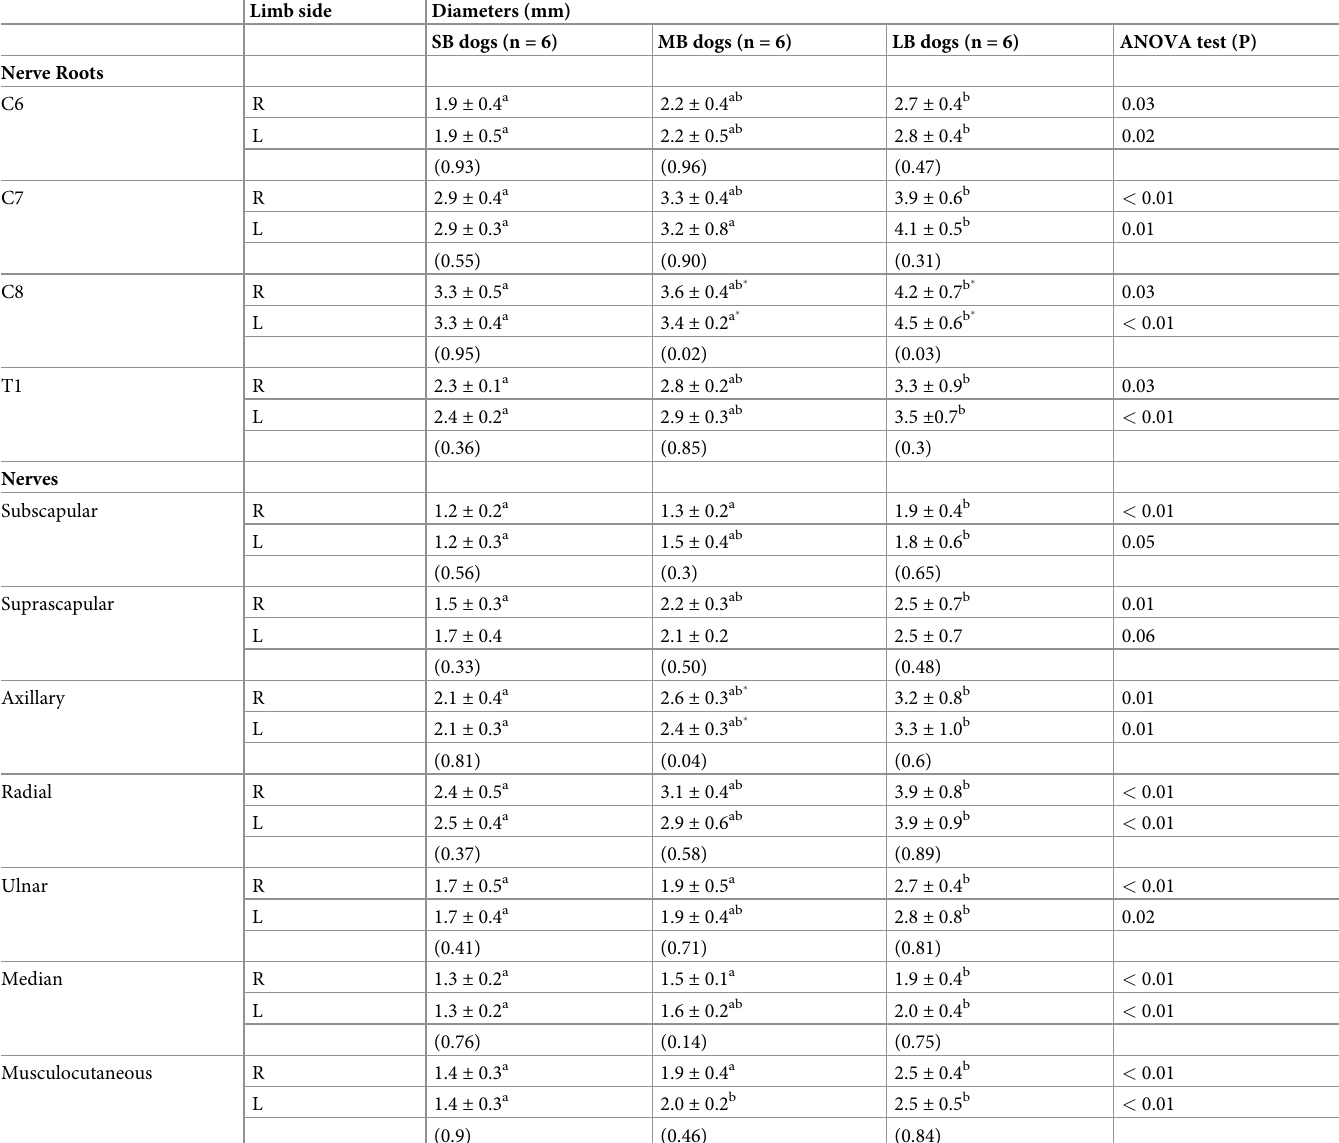
Table 2. Diameters of the nerve roots of the spinal nerves and of the nerves of the brachial plexus of the right (R) or the left (L) thoracic limbs from 18 canine cadavers. Limb